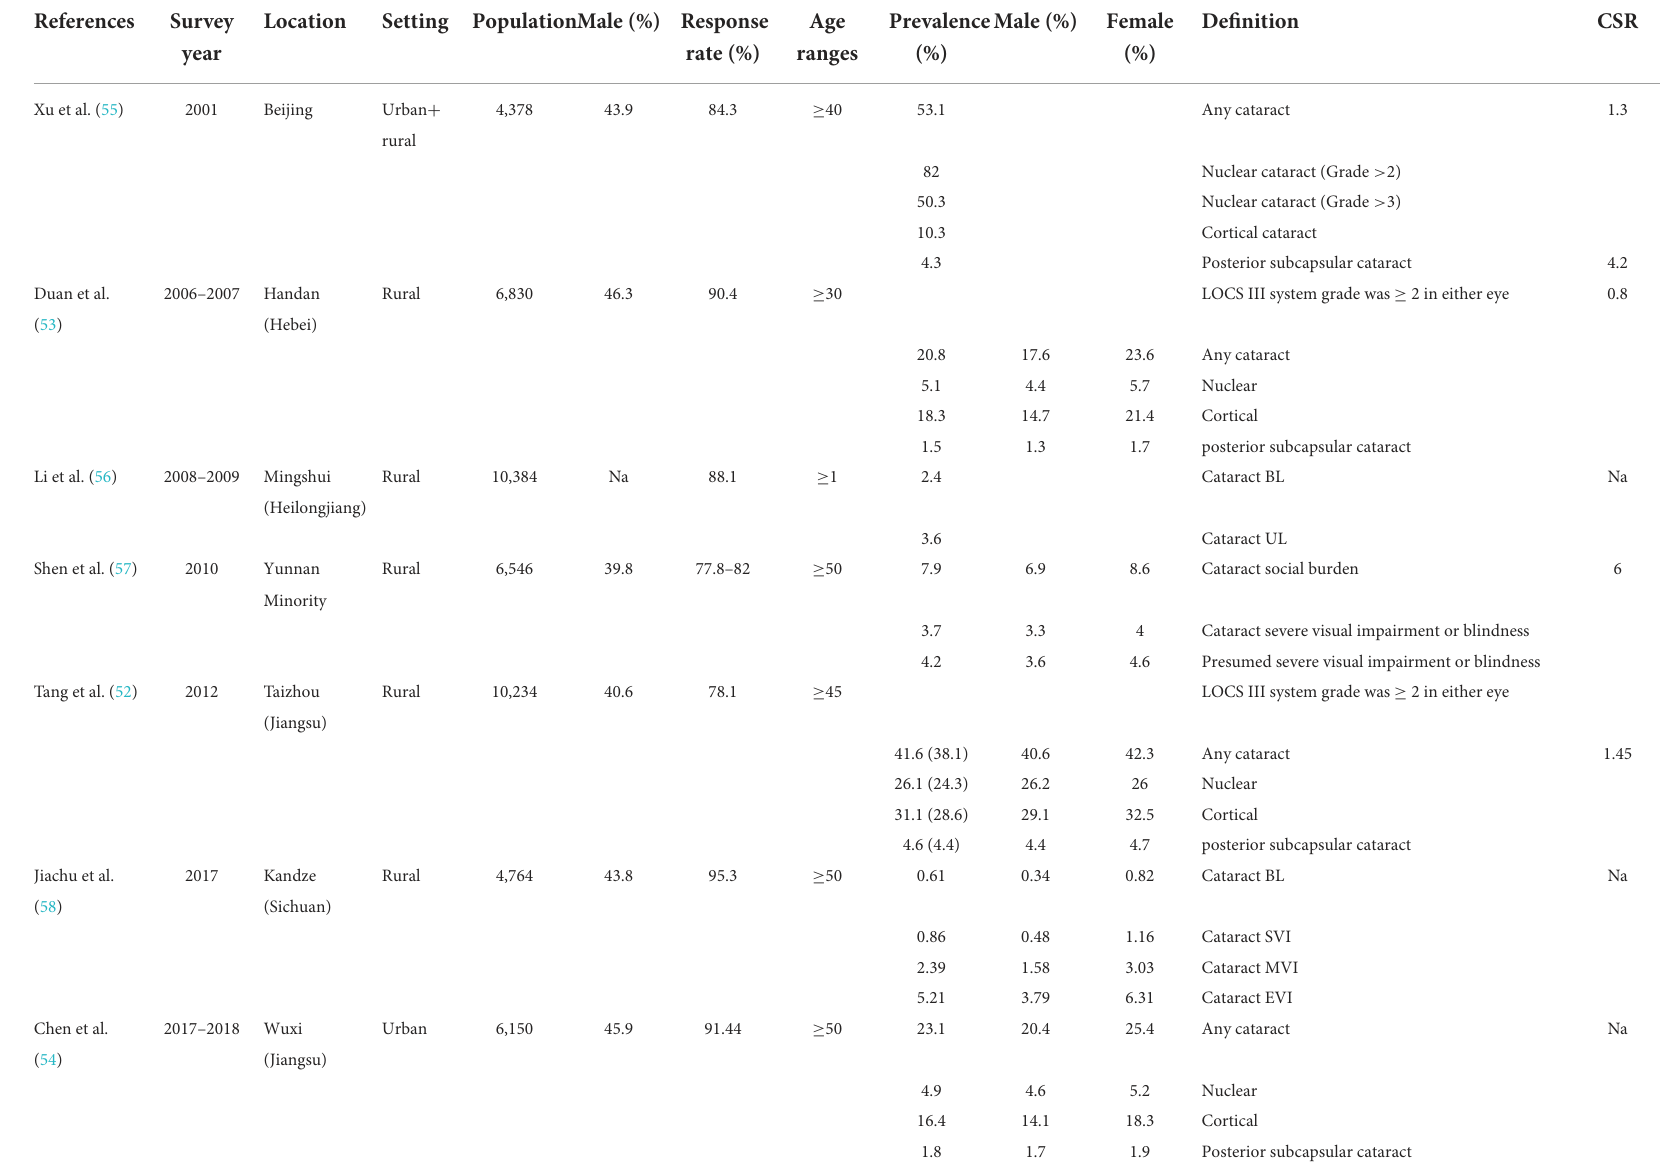
TABLE 1 Detailed characteristics of the main studies on cataract prevalence in mainland